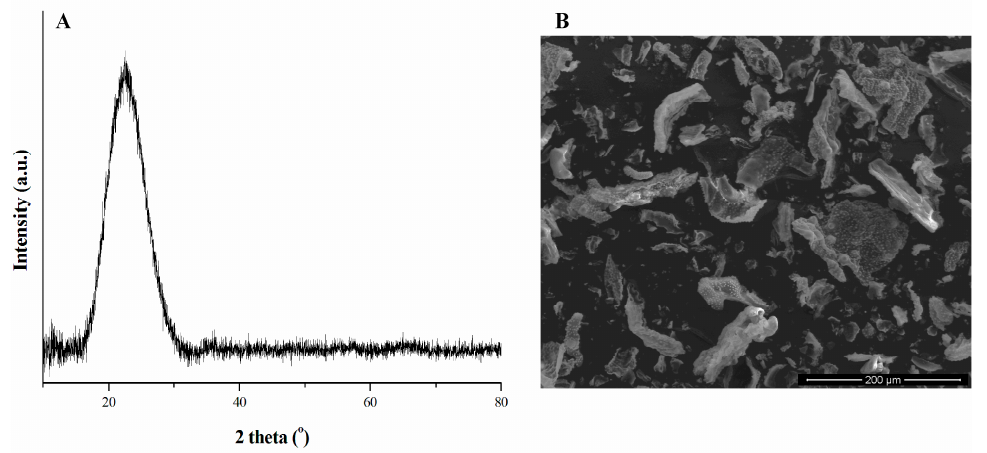
Figure 3. ( A ) XRD pattern of horsetail-derived silica powder, ( B ) SEM image of the powder, magnification 350× .